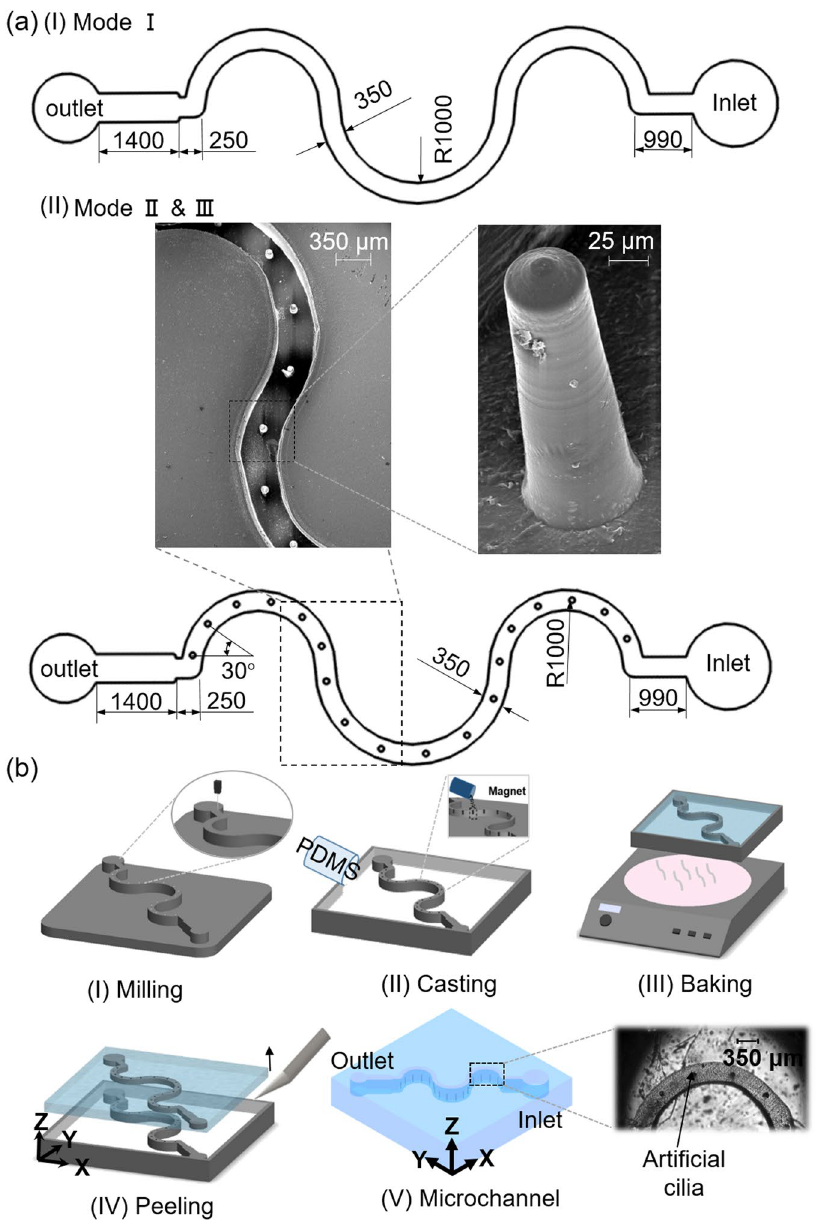
Figure 1. ( a ) Schematic illustration as well as the dimensional details of the serpentine microchannel. Three modes describe the three different experimental conditions. For Mode I: microchannel without cilia, Mode II: microchannel with static cilia, and for Mode III: microchannel with cilia rotating in a clockwise manner. All the dimensions are in μ m and the figures are not up to scale. The inset picture depicts the SEM picture of the section of a microchannel and the artificial cilia structure. ( b ) Schematic depiction of the microfabrication